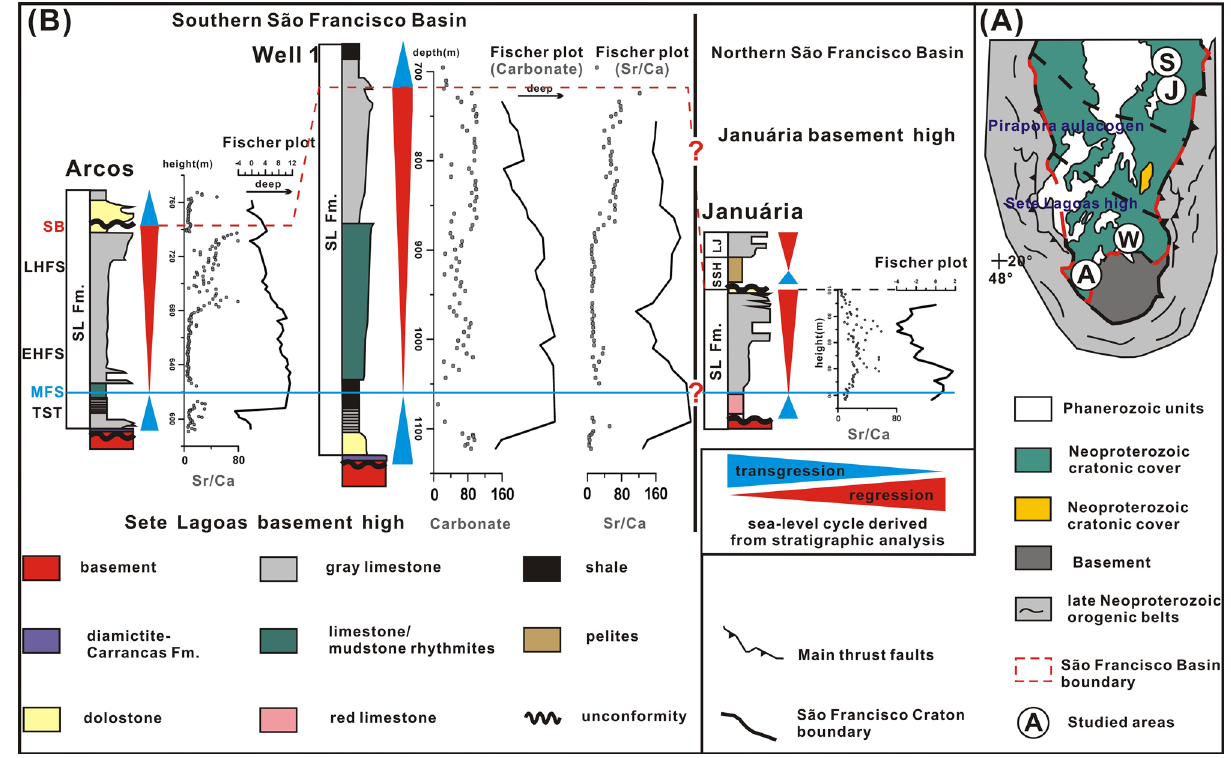
Figure 6. Geological map of the São Francisco Basin and locations of sampling sections ( A ) (Ref. 42 ). Fischer plots based on Sr/Ca ratios and carbonate content vs. sea-level cycle derived from stratigraphic analysis. MFS maximum flooding surface, SB sequence boundary, TST transgressive system tract, EHST early highstand system tract, LHST late highstand system